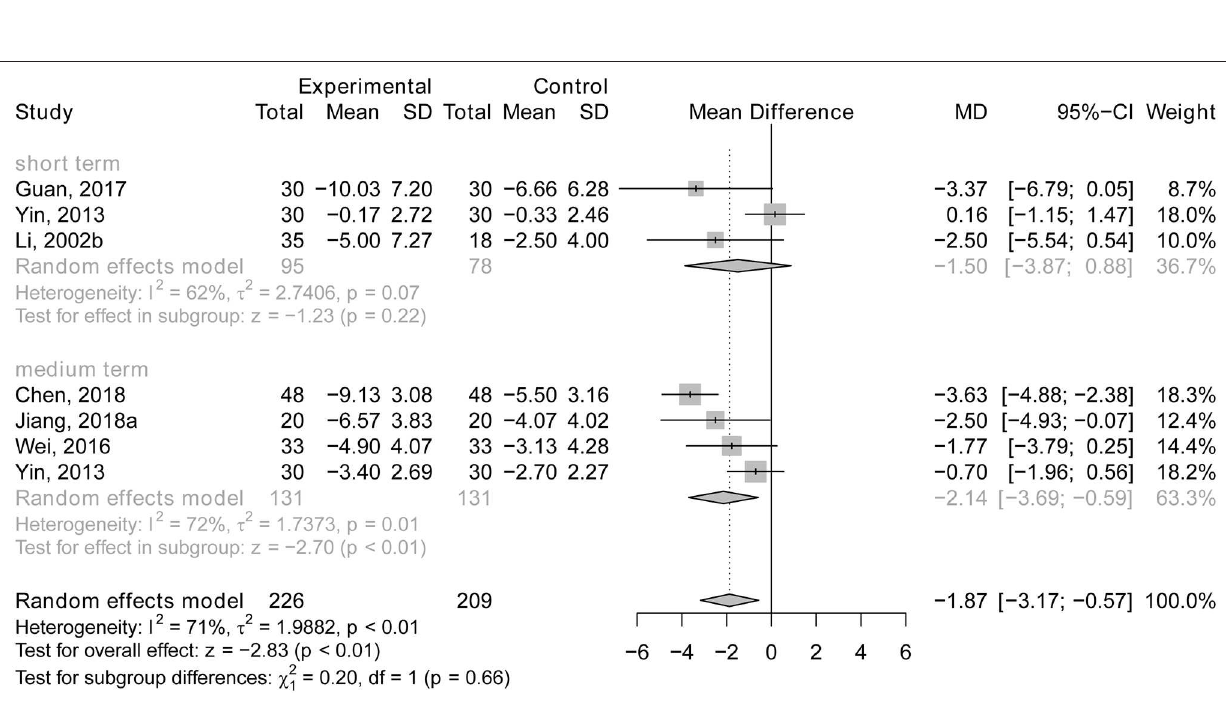
FIGURE 12 | The forest plot of ADL of acupuncture plus drug therapy vs. drug therapy alone. Li (2002b), acupuncture plus Dangguishaoyaosan vs. Dangguishaoyaosan; Jiang et al. (2018), acupuncture plus Jiannaosan vs. Jiannaosan.